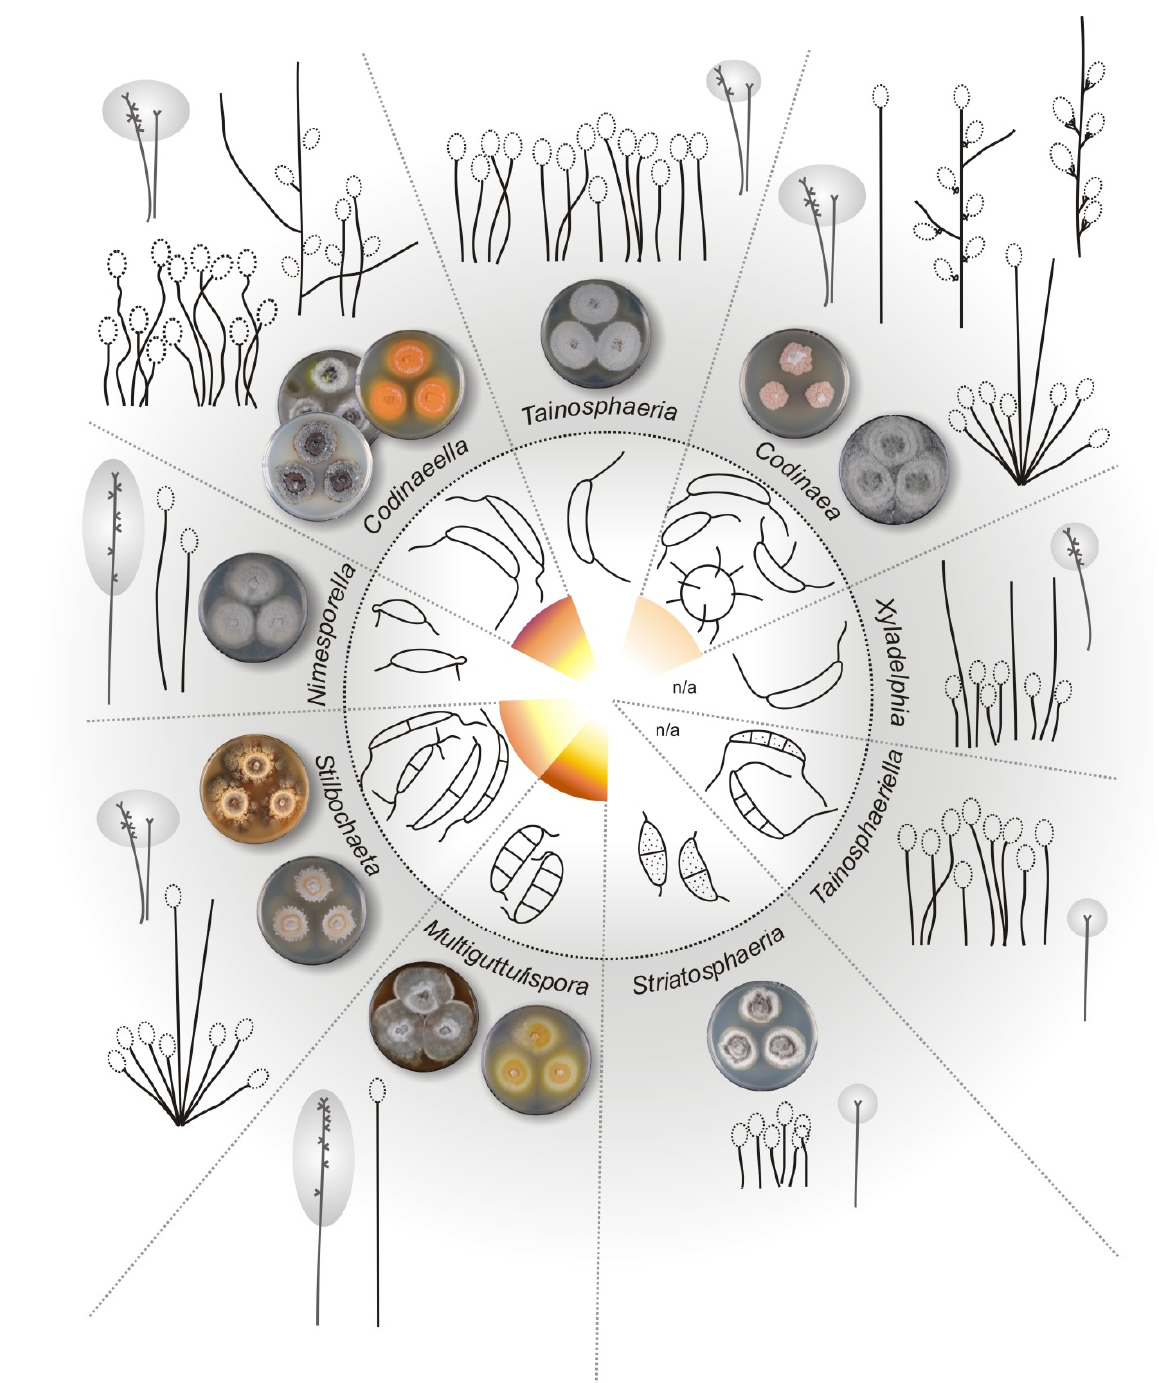
Figure 46. Morphotypes of Codinaea and similar genera with setulate conidia. Conidia and pigments formed in vitro are shown in the central (white) part of the wheel. The arrangement of conidiophores with setae, if present, of each genus, along with the morphology of the phialide (i.e., with a terminal or lateral opening) and colony characters are shown in the outer (grey) part of the wheel. Pigments diffusing in MLA and OA are shown by their respective colors and colony images; if no pigment is formed, the place at the centre is blank, n/a indicates that this information is not available.